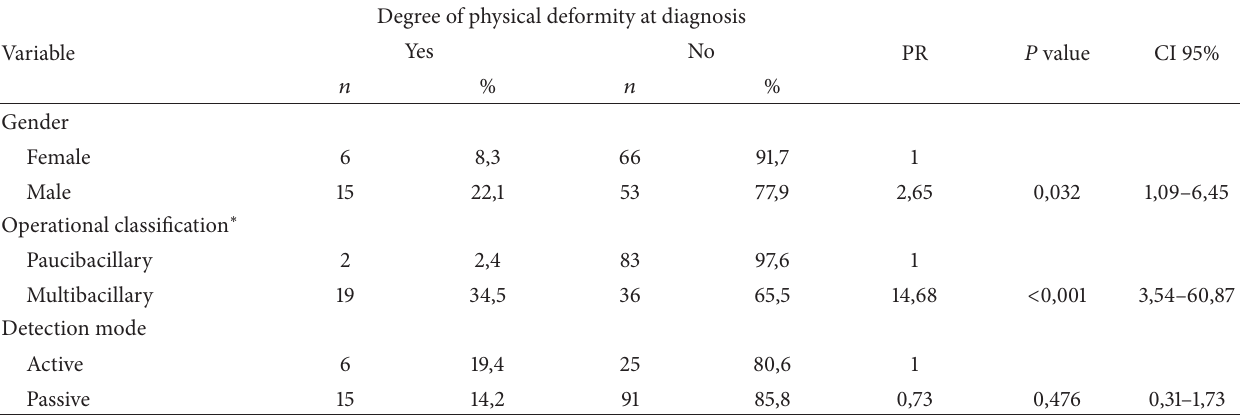
Table 3: Prevalence ratio and confidence intervals of factors associated with physical deformity of notified leprosy cases in children under 15 years old in Almenara, Arac¸ua´ı, and Diamantina between 1998 and